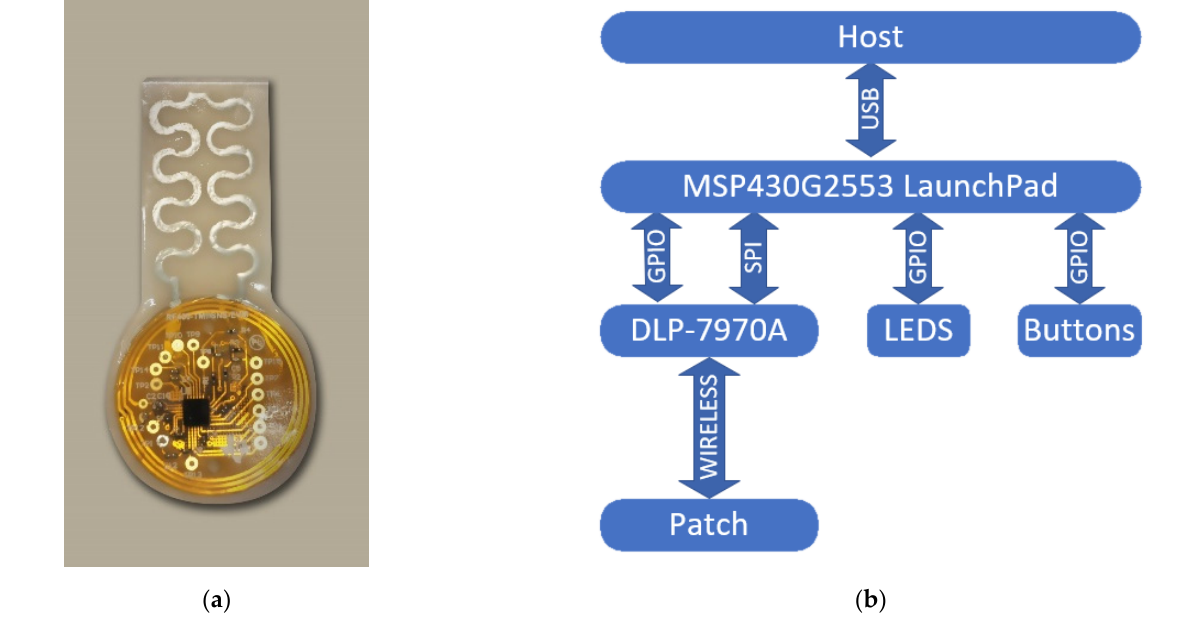
Figure 6. ( a ) Packaged skin-attachable multi-sensing patch; ( b ) Block diagram of the NFC card reader system working pattern.